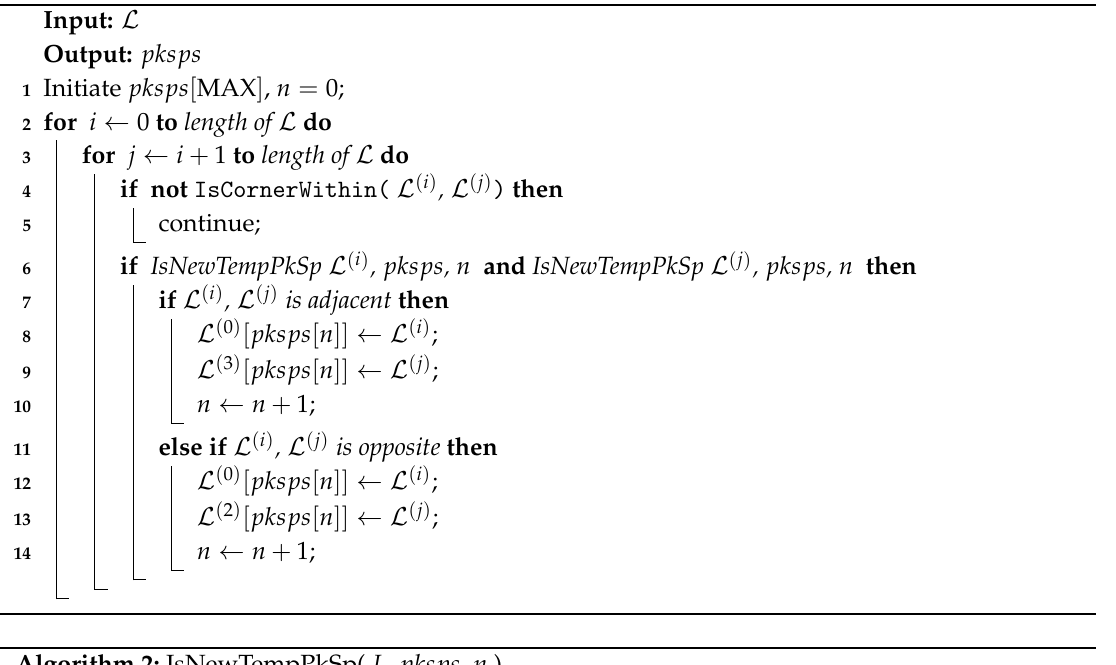
Algorithm 1: algorithm parking space search.